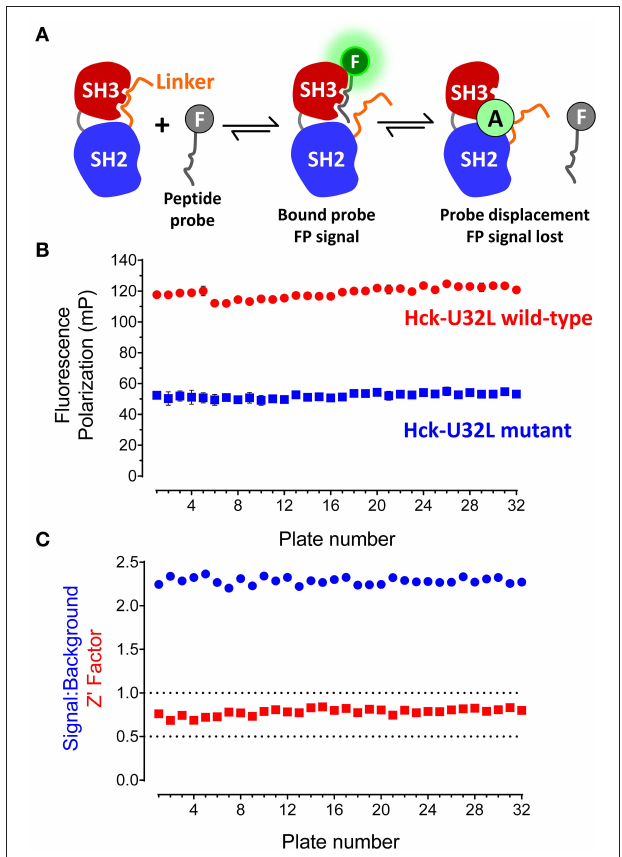
FIGURE 2 | FP-based HTS assay for SH3-SH2 ligands. (A) FP assay principle. The FP assay for Hck combines a recombinant N-terminal unique-SH3-SH2-linker (“U32L”) protein with an SH3-binding probe peptide labeled with fluorescein (F). Probe peptide binding to the SH3 domain in the target protein results in an FP signal. Small molecule allosteric modulators (A) may bind to the SH3 domain and block probe peptide binding directly as shown or stabilize SH3:linker interaction, making the SH3 domain inaccessible to the probe peptide ( not shown ). In either case, small molecule binding reduces the FP signal. The N-terminal region is not illustrated for clarity. (B) FP assay performance under robotic HTS conditions. The FP assay was automated and used to screen a 10,000-compound library using 32 × 384-well plates. Each plate had 32 wells of the target protein with DMSO only (Hck-U32L wild-type) and 32 wells of a protein with an inactivating mutation in the SH3 domain that cannot bind the probe as the negative control (Hck-U32L mutant). Average FP (mP) values from the control wells are shown ± S.D.; note that some error bars are smaller than the size of the corresponding data point. (C) Screening statistics. Signal-to-background ratios and Z’-factor coefficients calculated from control wells on each assay plate are